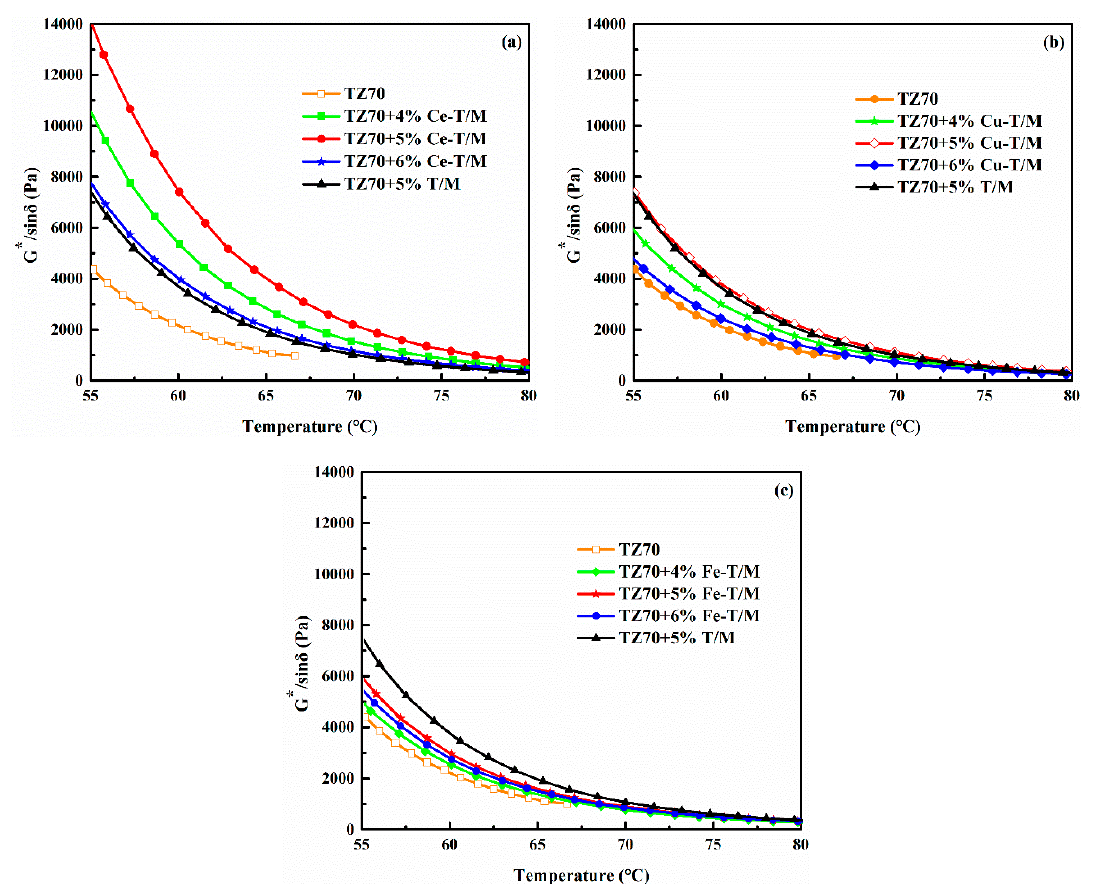
Figure 4. Variation of the G* / sin δ value of ( a ) Ce-T / M, ( b ) Cu-T / M, ( c ) Fe-T / M modified bitumen at different temperatures.